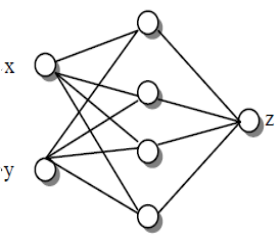
Figure 2. Network Perceptron with a Hidden Layer for the Interpolation Heights